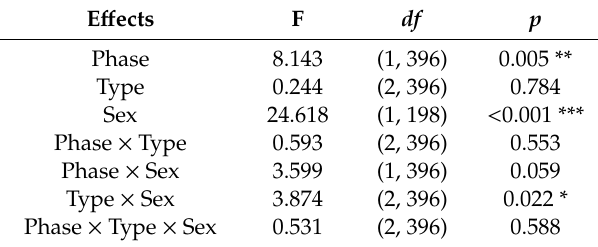
Figure 2. Performance on the immediate and delayed recall phases of the WSMT for each word type, by sex. Significance values indicated as follows * p < 0.05 or 95% CI; ** p < 0.01; *** p < 0.001. Table 2. Repeated measures factorial ANCOVA comparing the number of words recalled at the immediate and delayed recall Work-Stress Memory Task (WSMT), for each word type, by